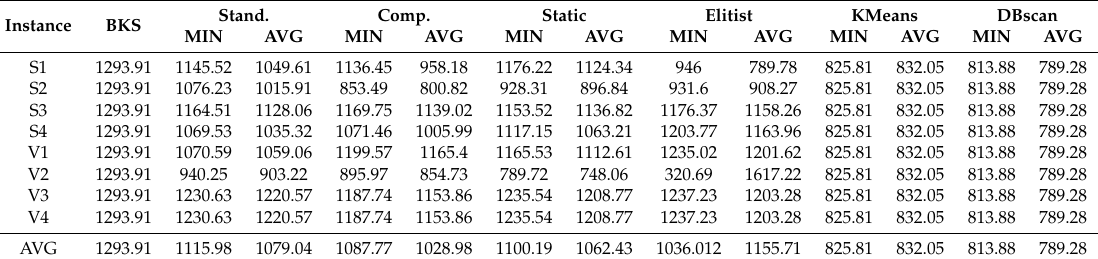
Table 7. CSA/KP—Two-steps vs. KMeans vs. DBscan resume summary.